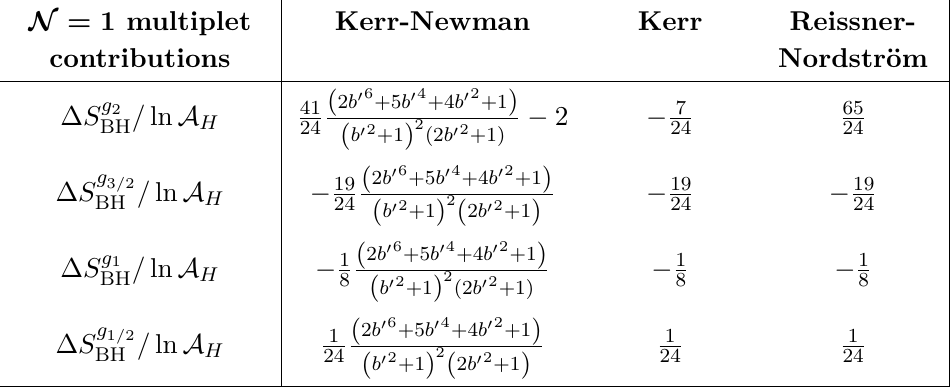
Table 3 . Logarithmic correction contributions of the multiplets of the decomposed N = 1 , d = 4